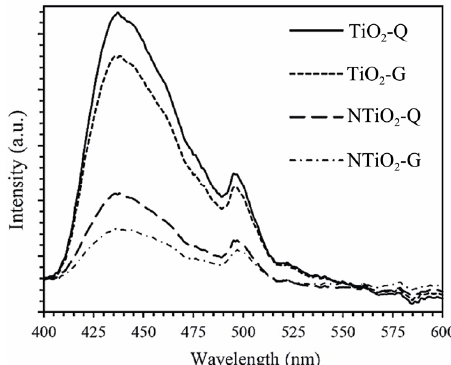
Fig. 7 PL spectra of the prepared thin film